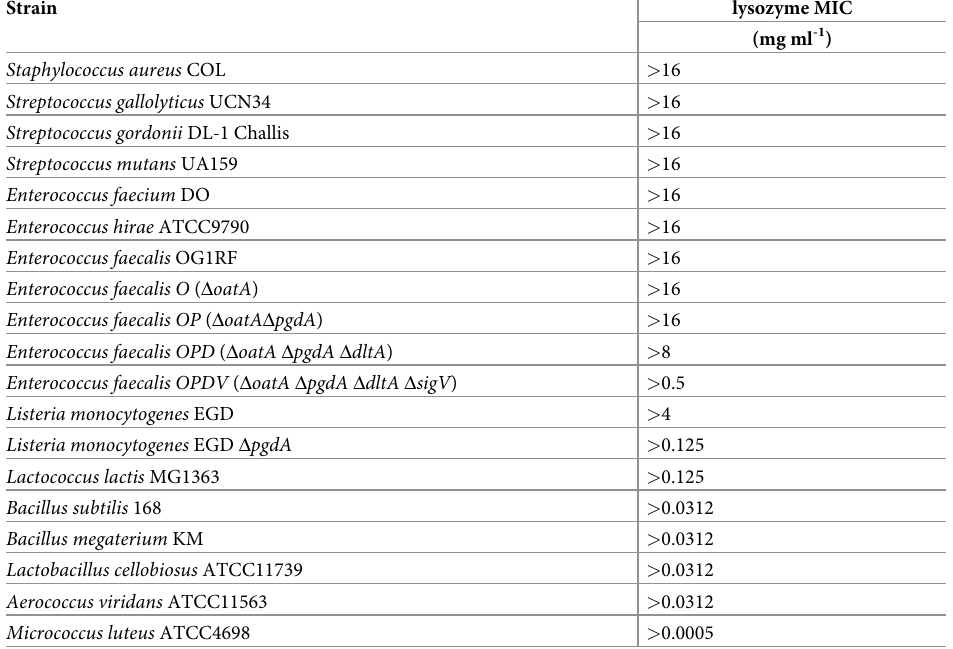
Table 1. MIC of lysozyme for